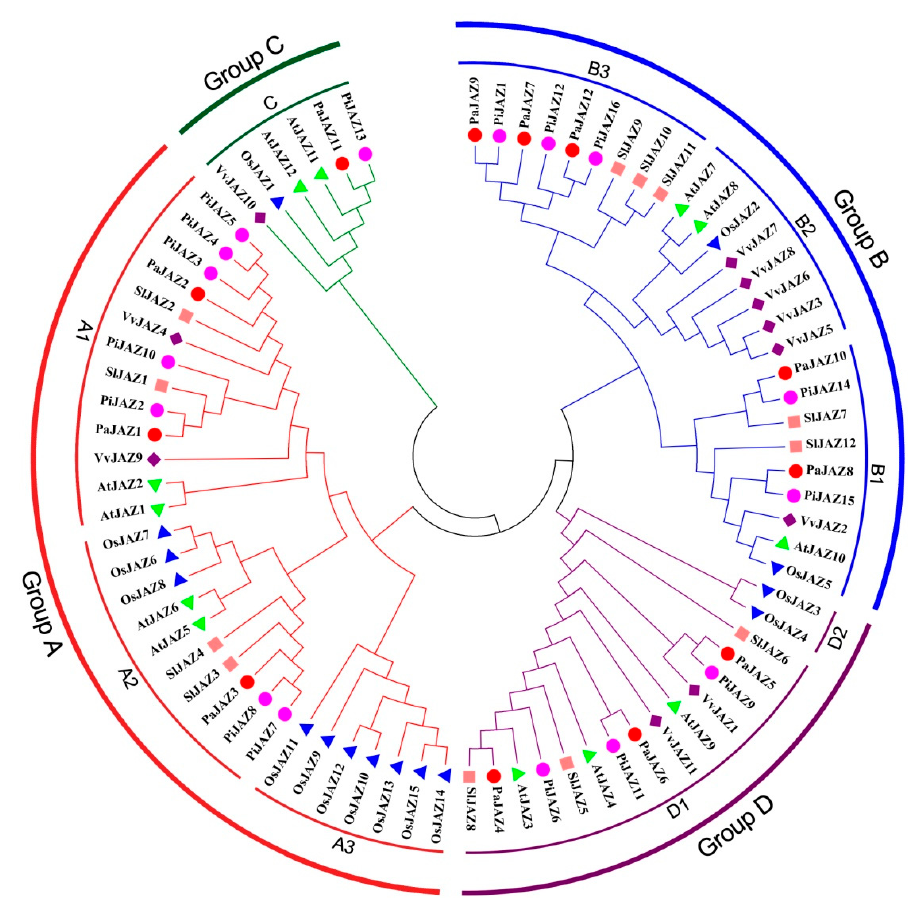
Figure 1. Phylogenetic tree for JAZ protein family from petunia, Arabidopsis , grape, rice, and tomato. MEGA 7.0 was adopted for phylogenetic analysis by using the Neighbor Joining (NJ) method with 1000 replicates of bootstrapping to test the reliability.